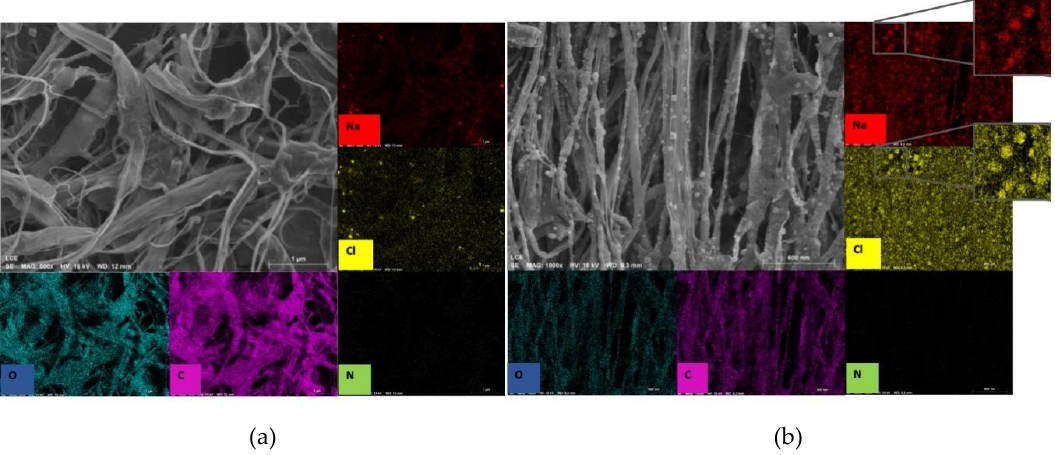
Figure 4. EDX map from the conditions of experimental design resulting in samples ( a ) 5 and ( b ) 12.